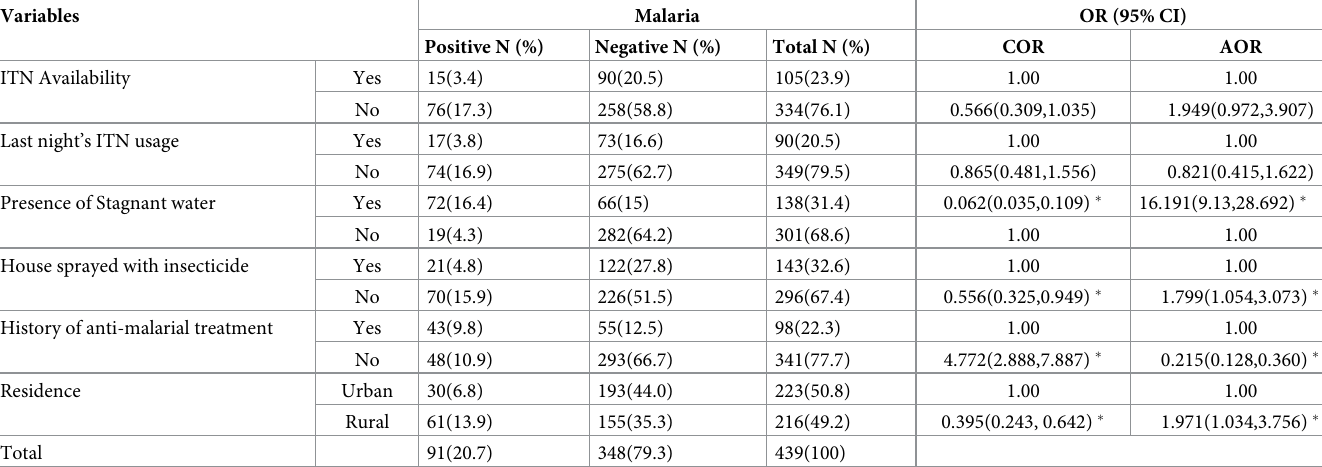
Table 2. Bivariate and multivariable analysis of factors associated with malaria infection concerning ITN availability, ITN usage, presence of stagnant water, indoor residual spray, history of malaria treatment, and residence at MTUTH, 2021 (n = 439).